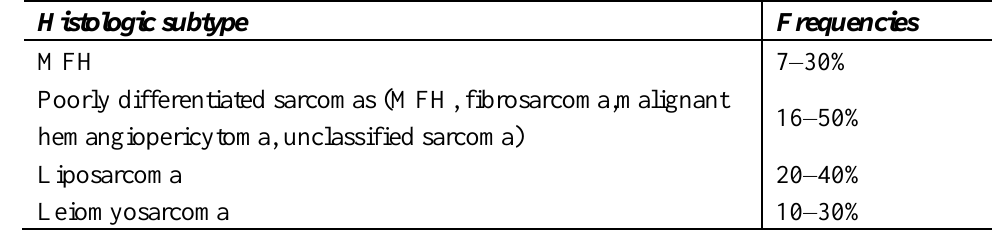
Table 2. Histologic subtypes and individualized frequencies of retroperitoneal sarcomas diagnosed in